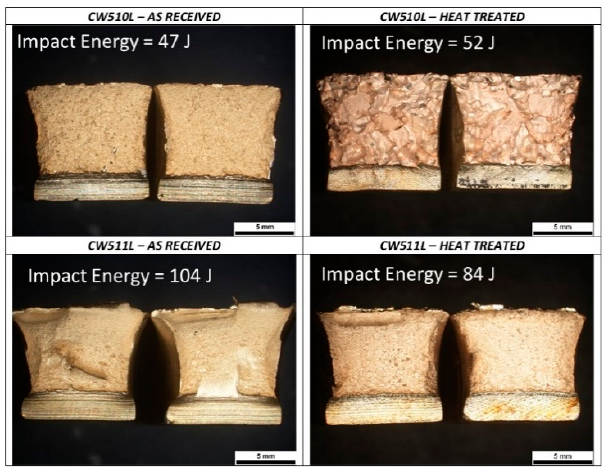
Figure 2. Macroscopic fracture surfaces after impact fracture toughness tests (Charpy) before and after heat treatment of CW510L and CW511L brass alloys. The average values of the induced impact energies are referred